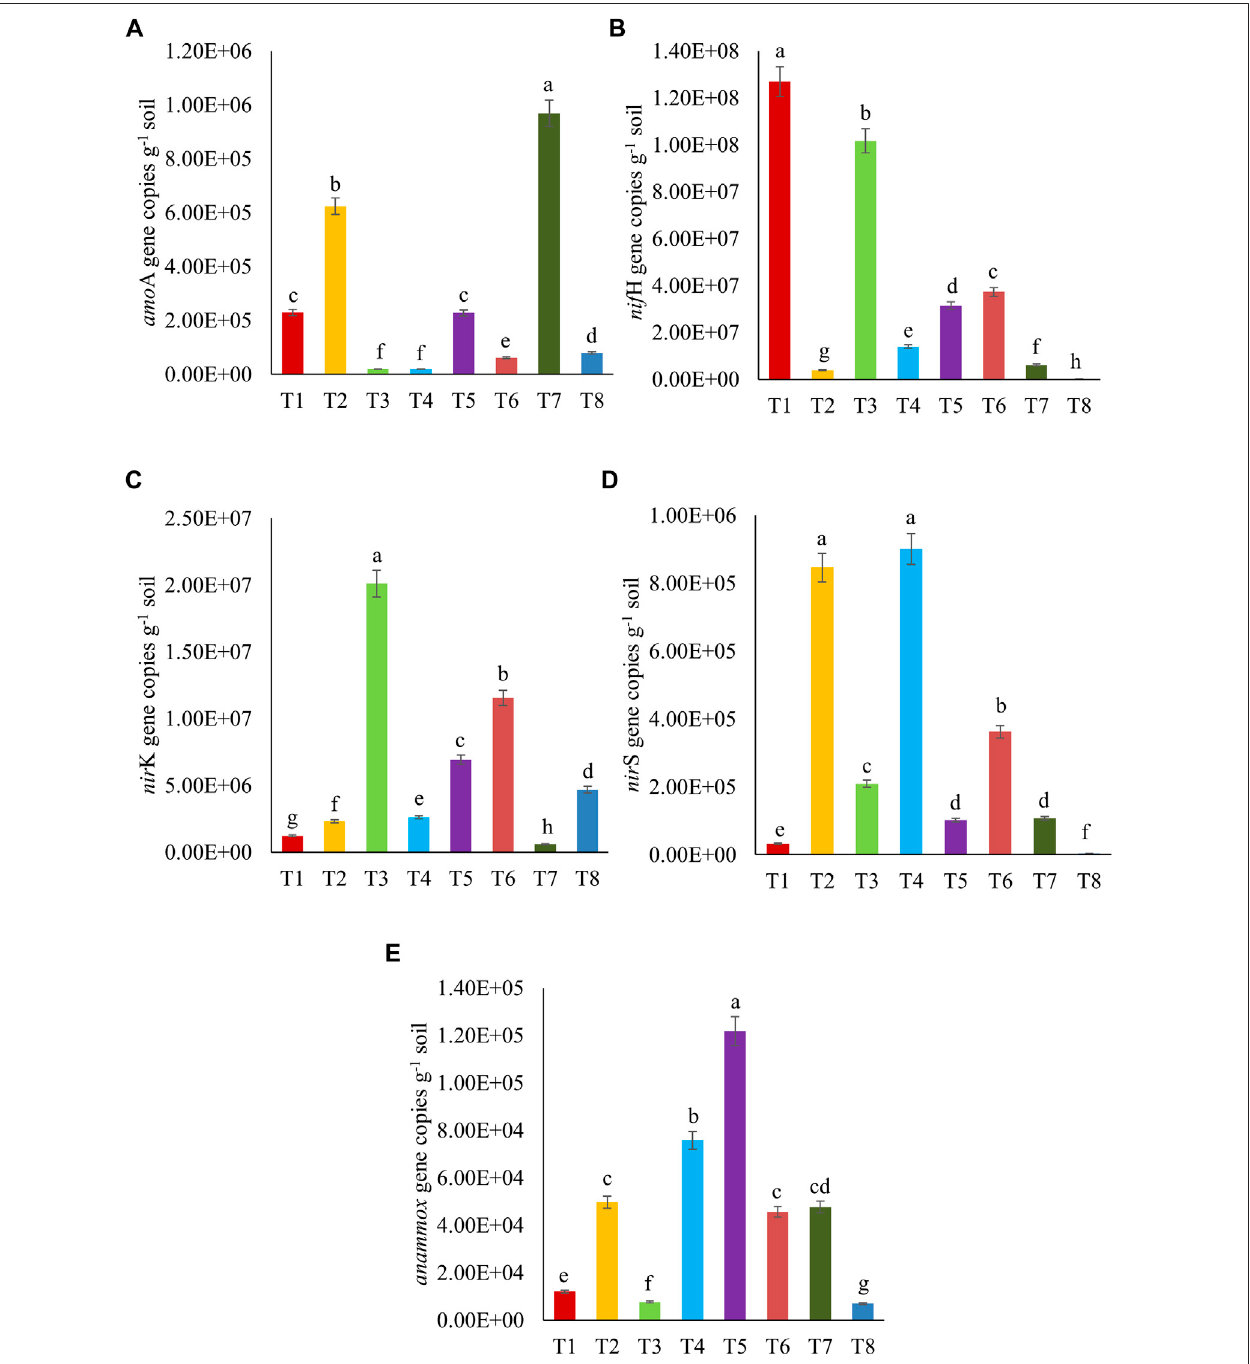
FIGURE 5 | Abundances of microbial functional gene copies of (A) amo A, (B) nif H, (C) nir K, (D) nir S, and (E) anammox related to nitrogen cycling after 10 th day of crude oil forti fi cation in the sandy loam soil [T1 – soil; T2 – soil + crude oil (1%); T3 – soil + crude oil (1%) + bacterial consortia ( Pseudomonas sp. A3 + Bacillus amyloliquefaciens A9);T4 – soil+crudeoil(2%)+bacterialconsortia( Pseudomonas sp.A3+ Bacillusamyloliquefaciens A9);T5 – soil+crudeoil(5%)+bacterialconsortia ( Pseudomonas sp. A3 + Bacillus amyloliquefaciens A9); T6 – soil +crude oil (1%)+ fungus ( Aspergillus sydowii AK20); T7 – soil + crude oil (2%) + fungus ( Aspergillus sydowii AK20); T8 – soil + crude oil (5%) + fungus ( Aspergillus sydowii AK20)].